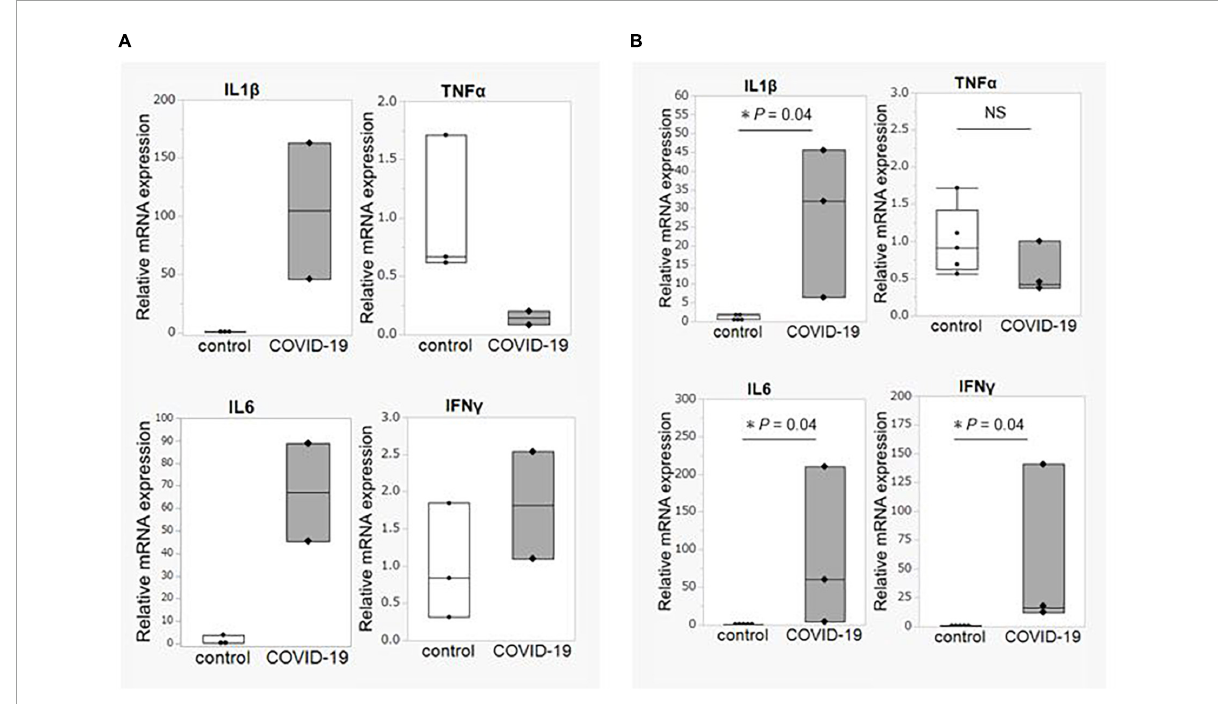
FIGURE4 Intestinal mucosal gene expression of inflammatory cytokines. (A) Comparison of gene expression of inflammatory cytokines between COVID-19 patients ( n = 2) and healthy controls ( n = 3) in the ileum. (B) Comparison of gene expression of inflammatory cytokines between COVID-19 patients ( n = 3) and healthy controls ( n = 5) in the colon. Statistical analysis was performed using the Wilcoxon rank sum-test. Statistical significance was accepted as P < 0.05. NS means P > 0.05. IL, interleukin; TNF, tumor necrosis factor; IFN, interferon.